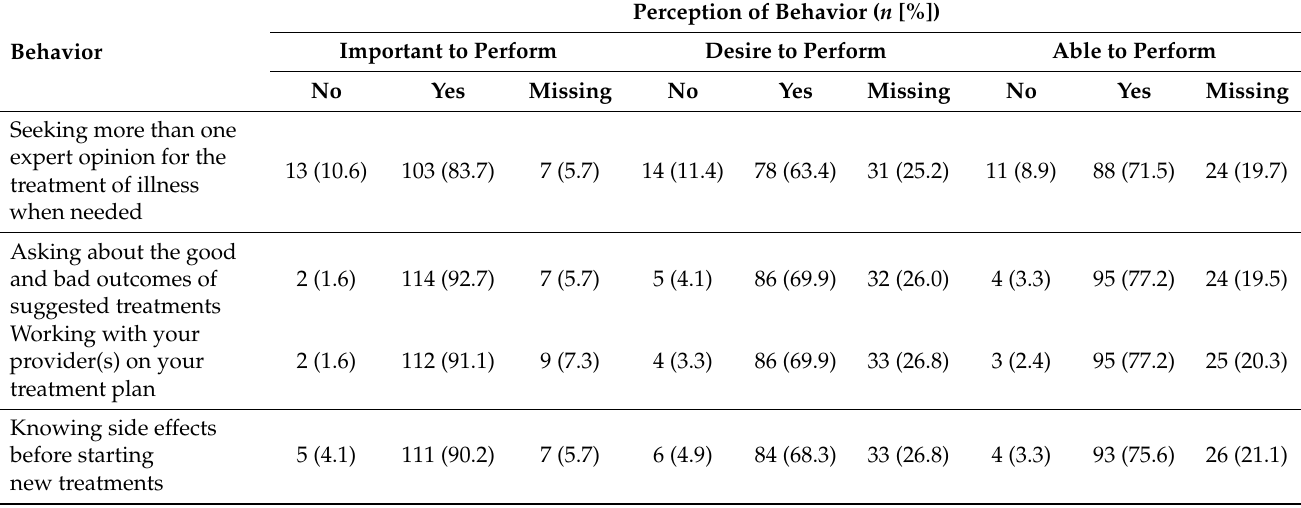
Table 2. Perspectives on self-care behaviors from the 123 older community-dwelling adult